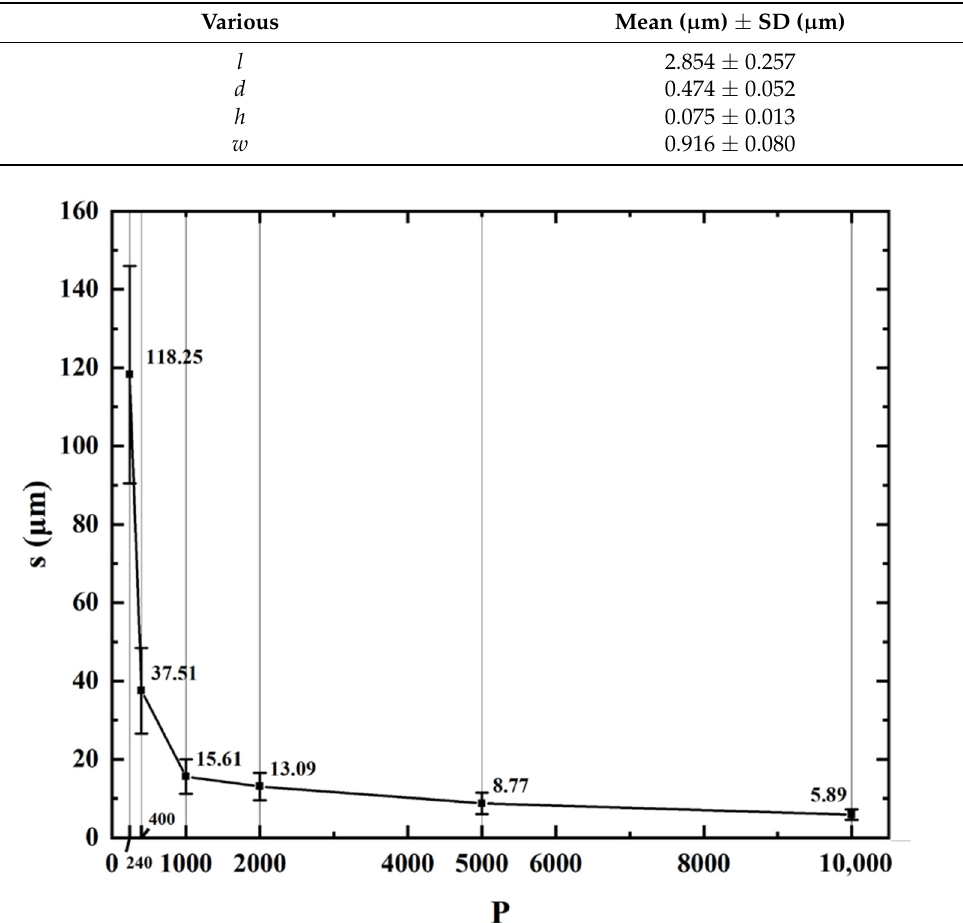
Table 1. Topography dimensions on microstructures of ventral scales of D. rufozonatum. .